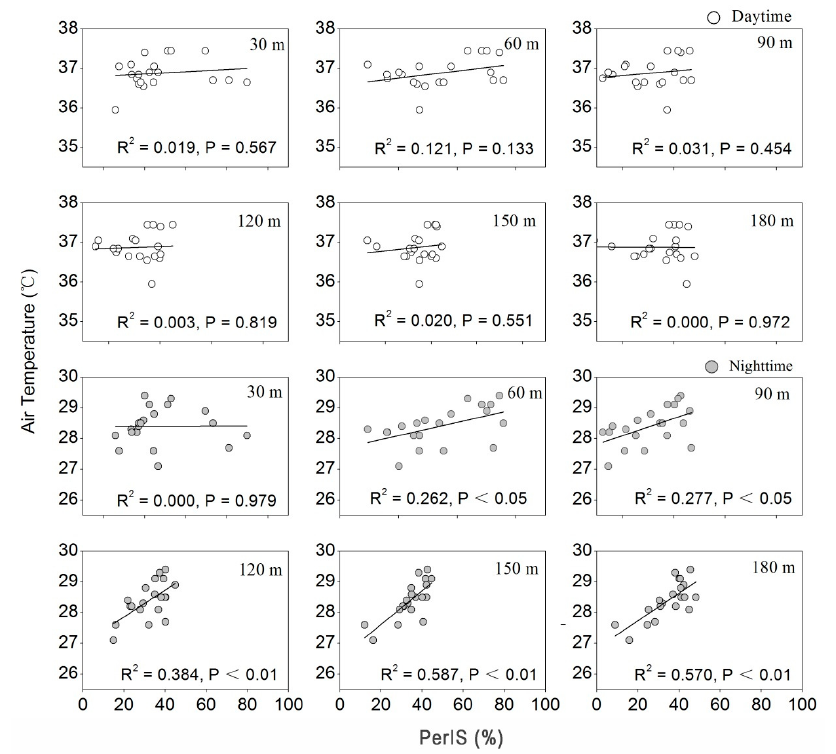
Figure 6. Relationships between air temperature and the percentage of impervious surface in different radii.